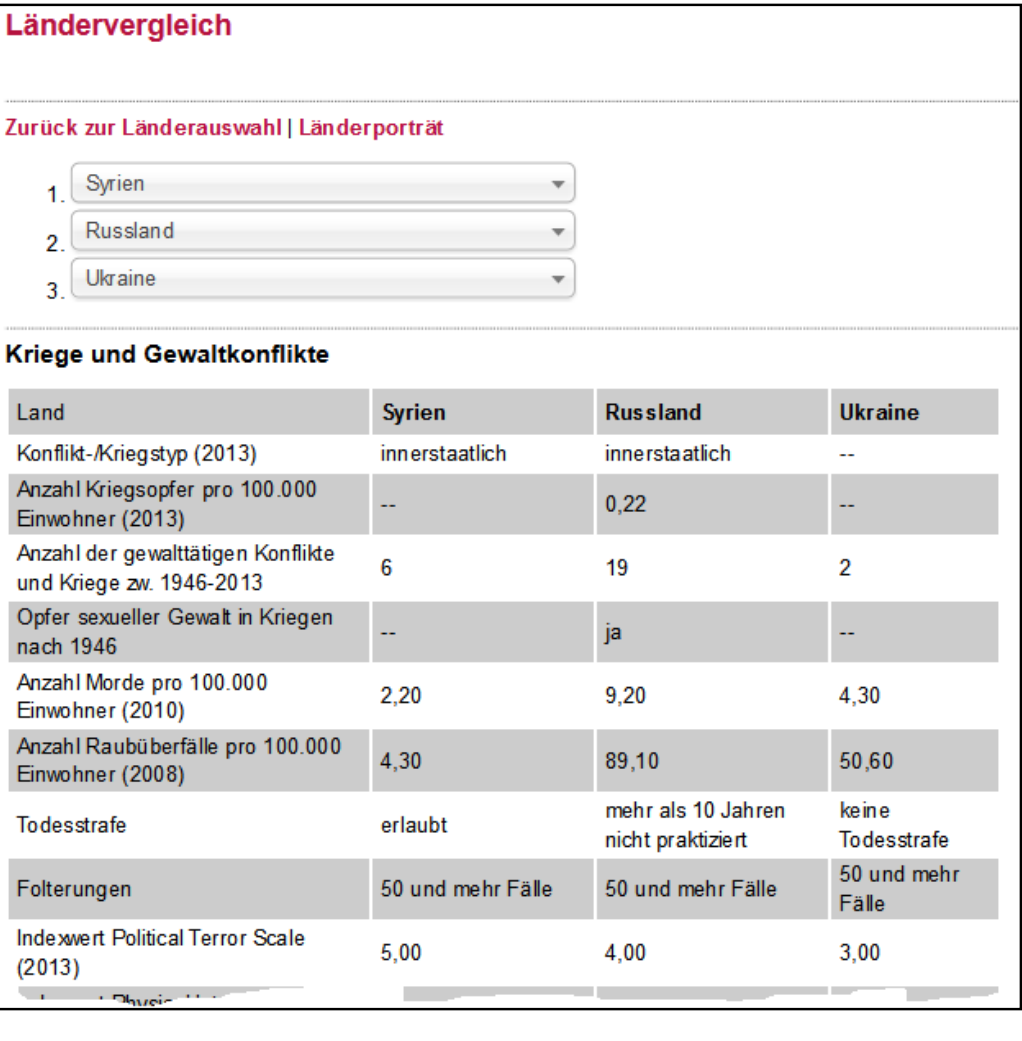
Figure 5. Screenshot—Country comparison function 4. Content Addressed by the Information